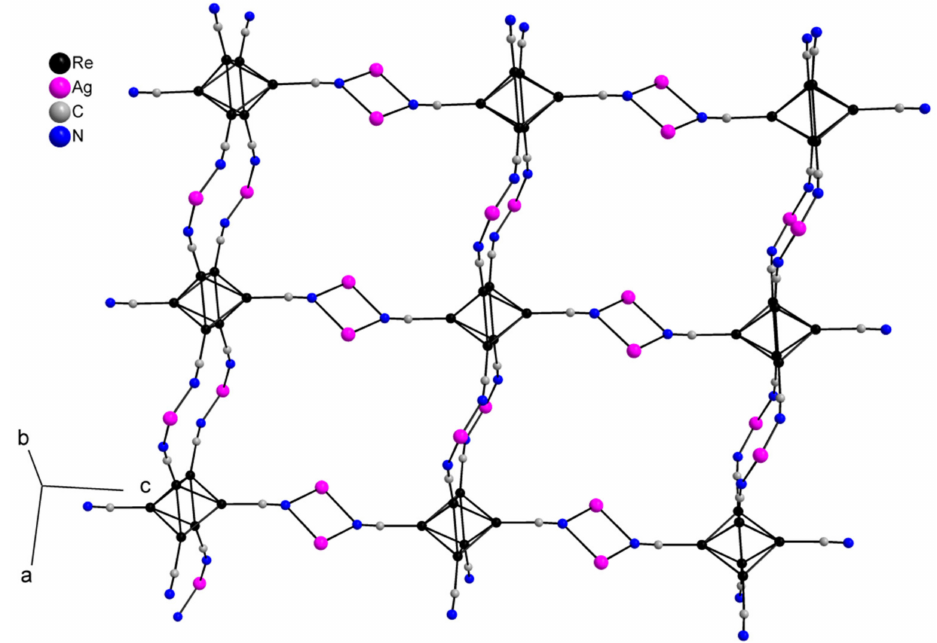
Figure 5. A layer structure of compound 1 . Se atoms and phen molecules are omitted for clarity.